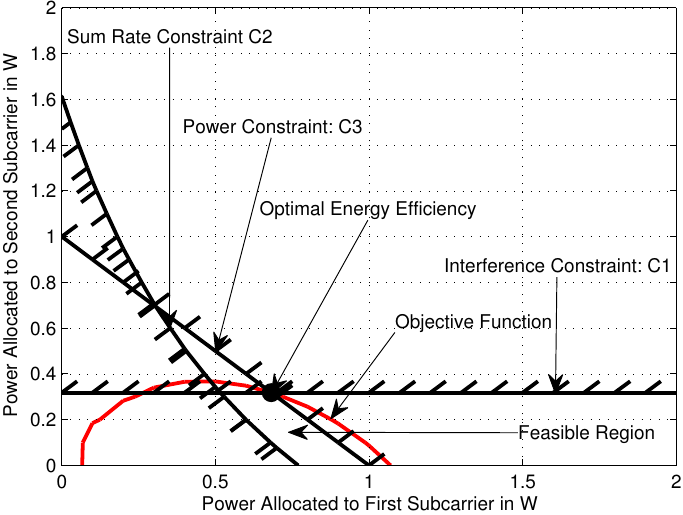
Figure 3. Pictorial view of the optimization objective and all the constraints for different rate constraint. The feasible region and the optimal solution point are also shown in this